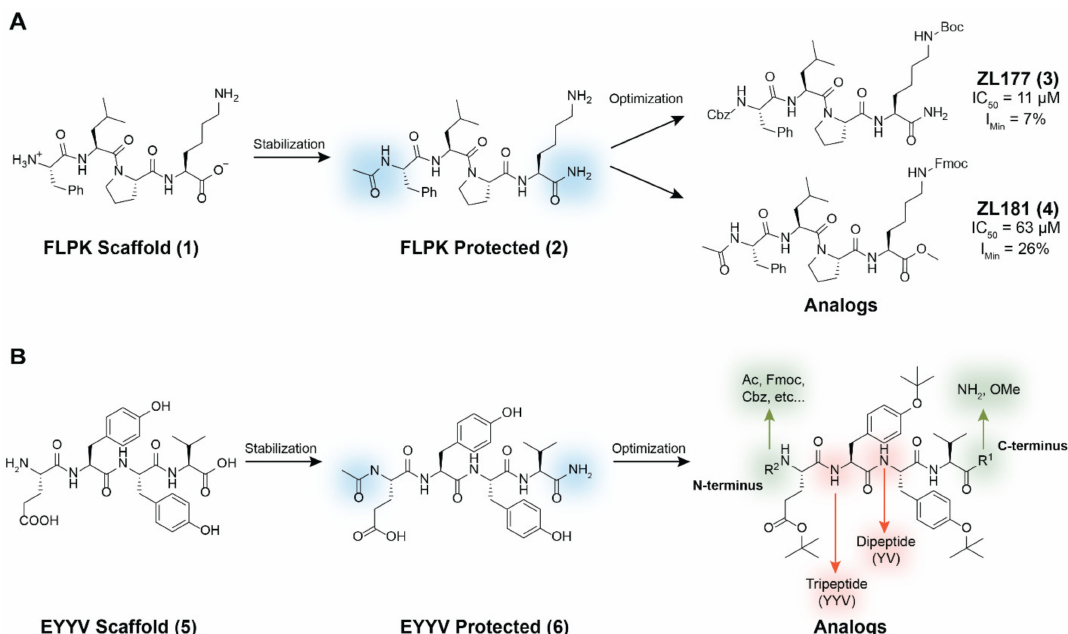
Figure 1. Structural modification strategy for development of peptidomimetics based on hot segments of FGF14 at its interface with Nav1.6. ( A ) The previously reported parental peptide Phe-Leu-Pro-Lys (FLPK) and its analogs, ZL177 ( 3 ) and ZL181 ( 4 ). ( B ) Structural modification strategy for development of chemical probes derived from the Glu-Tyr-Tyr-Val (EYYV) sca ff